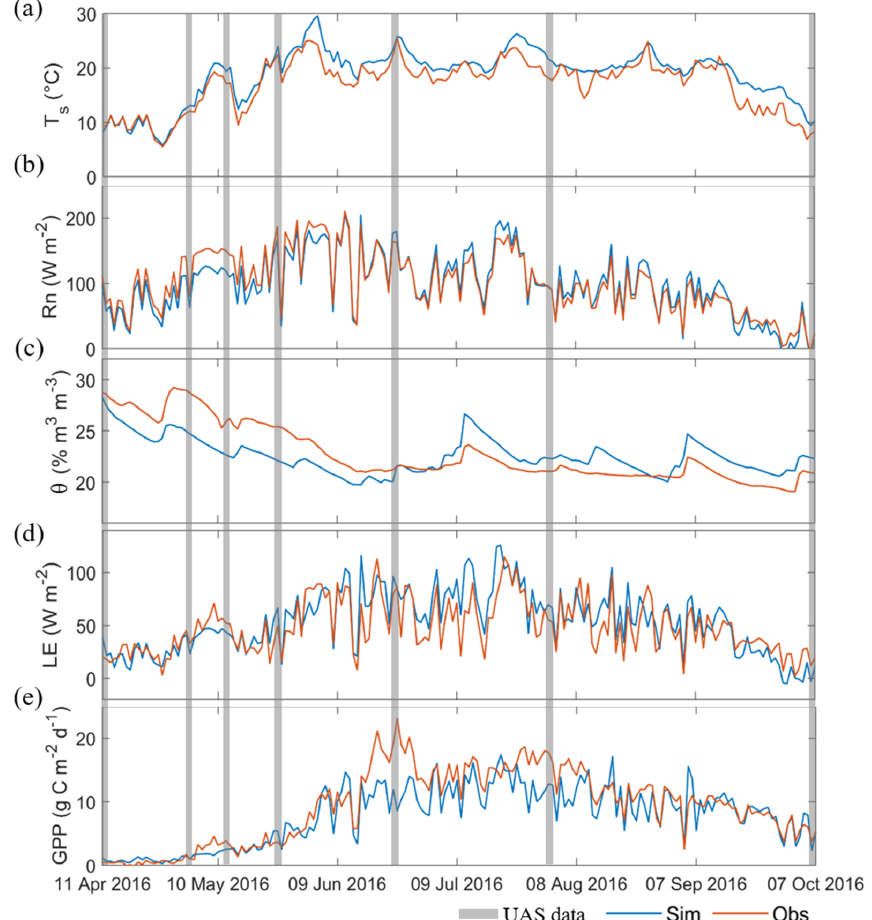
Figure 6. Simulated continuous daily land surface variables from 11 April to 7 October 2016 at the willow plantation: (a) land surface temperature ( T s ), (b) net radiation ( R n ), (c) soil moisture( θ ), (d) latent heat flux ( LE ), and (e) gross primary productivity (GPP). The grey shaded area indicates the time of acquired data for model calibration, and the blue and red curves represent simulations and observations